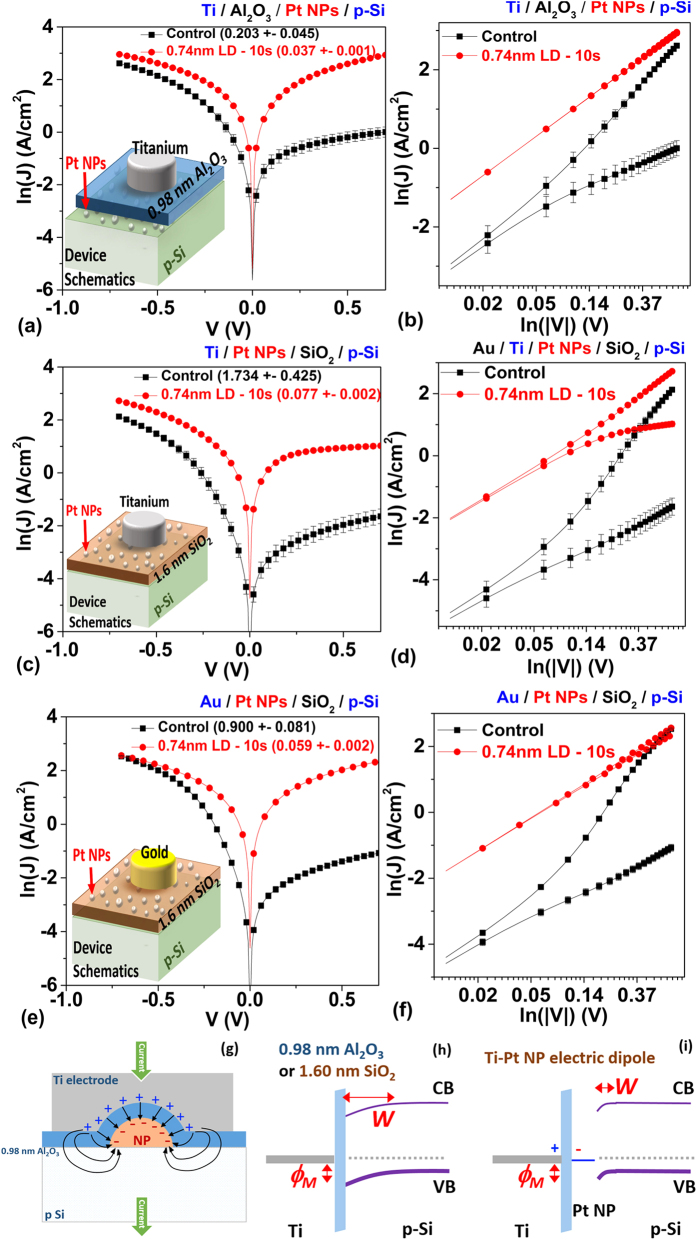
Comparison of Ln(J)-V characteristics for (a) Ti-Al2O3-p Si contact with and without 0.74 nm LD Pt NPs between the Al2O3 and Si surface; (c) Ti-SiO2-p Si contact with and without 0.74 nm LD Pt NPs between the Ti electrode and SiO2 surface; (e) Au-SiO2-p Si contact with and without 0.74 nm LD Pt NPs between the Au electrode and SiO2 surface; Inset: Schematics of the device structures. (b,d,f) The corresponding Ln(J)- Ln(|V|) characteristics of (a,c,e,g) schematics showing the dipole formation between Ti electrode and Pt NP; (h,i) schematics of energy band diagram showing the reduction of depletion width and barrier height with the present of the Pt NPs.